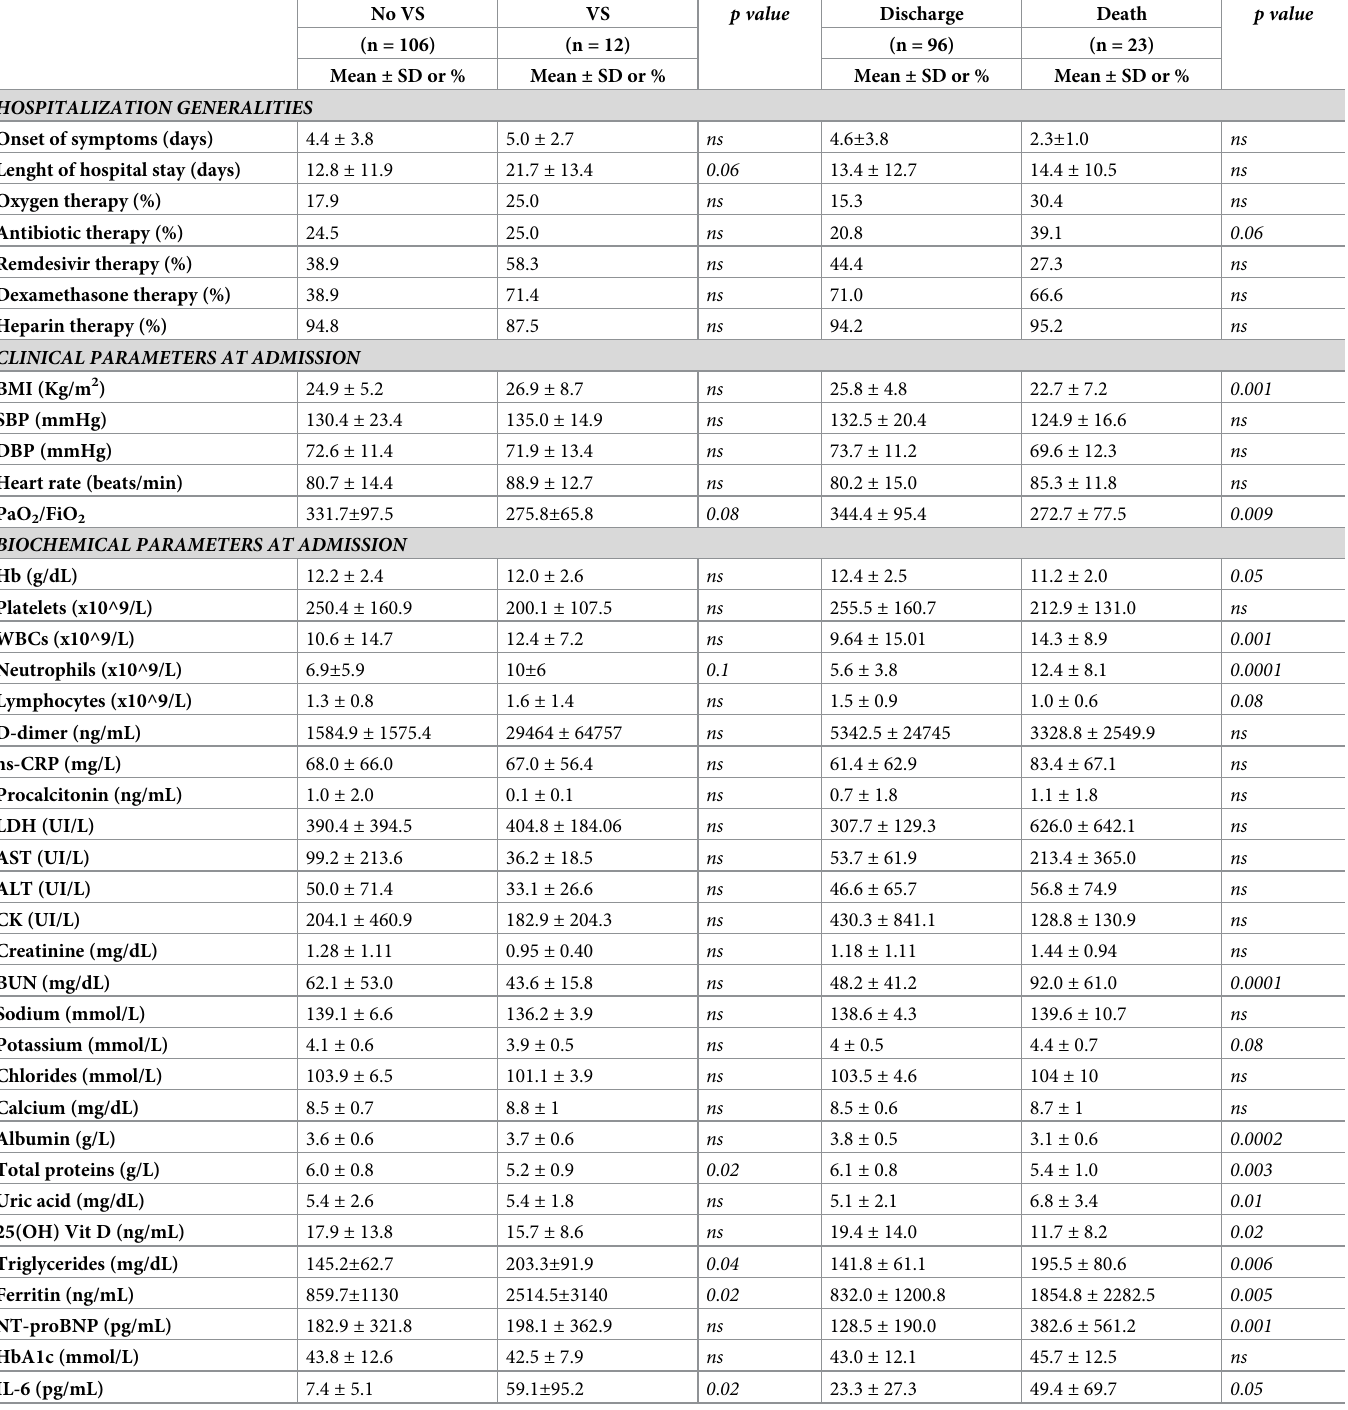
Table 2. Baseline clinical parameters of COVID-19 patients who presented unfavorable outcomes (ventilation support need and death) and those who did